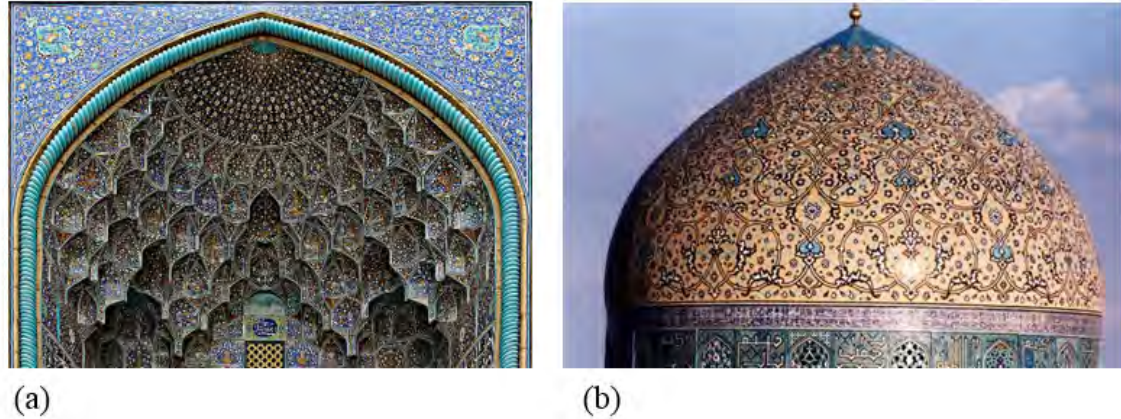
Figure 3. Isfahan Masjid (a) Entrance Muqarnas; (b) Main